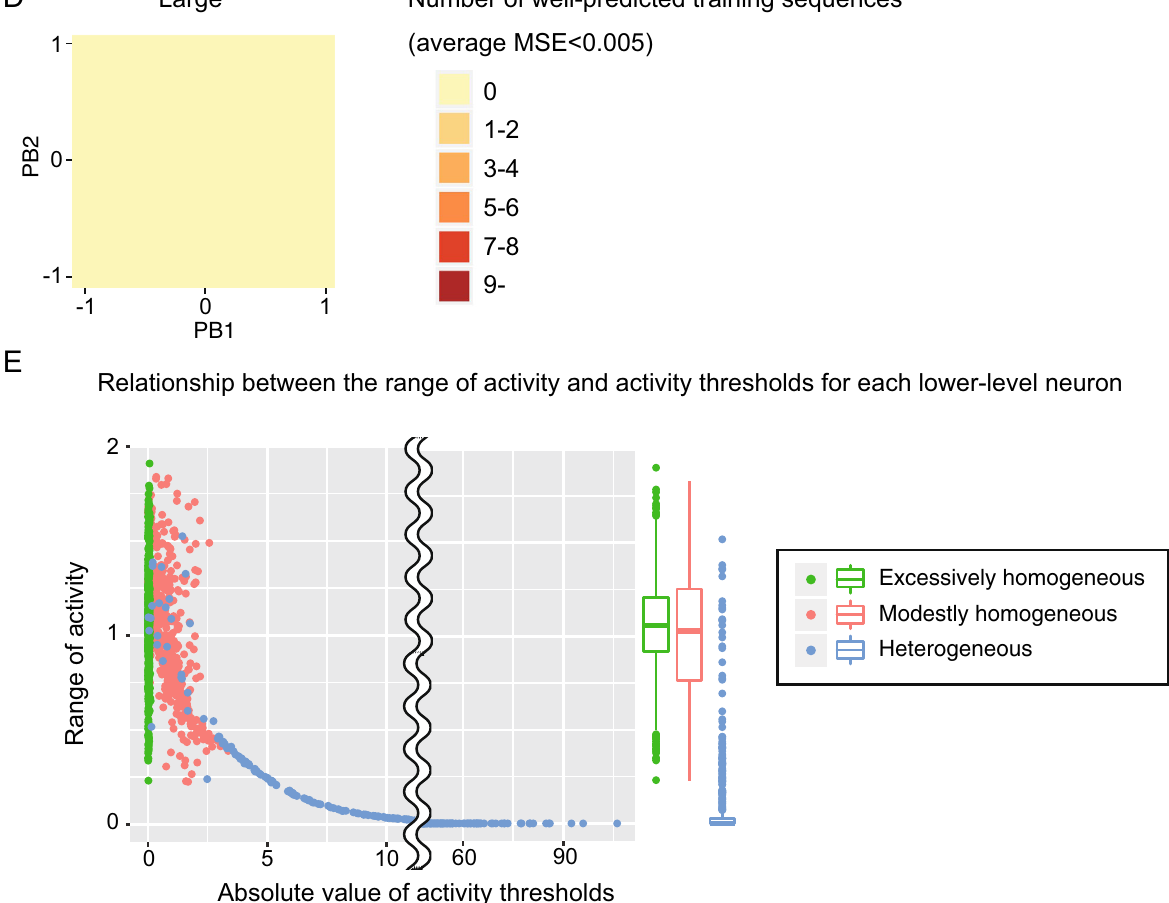
Figure 5. ( A–D ) Tolerance of higher-level neural representations. The heat maps show the numbers of well- predicted training sequences (i.e., average MSE < 0.005) varying with the PB activities. ( E ) Relationship between the range of activity and activity thresholds for each lower-level neuron. The X axis indicates the absolute values of activity thresholds for each lower-level neuron. The Y-axis indicates the range of activity (i.e., difference between the maximum and minimum outputs) for each lower-level neuron. The boxplots shows the distribution about the range of activity of lower-level neurons. PB parametric bias, MSE mean squared error. The figures were created using R software 45 and the ggplot2 library 46